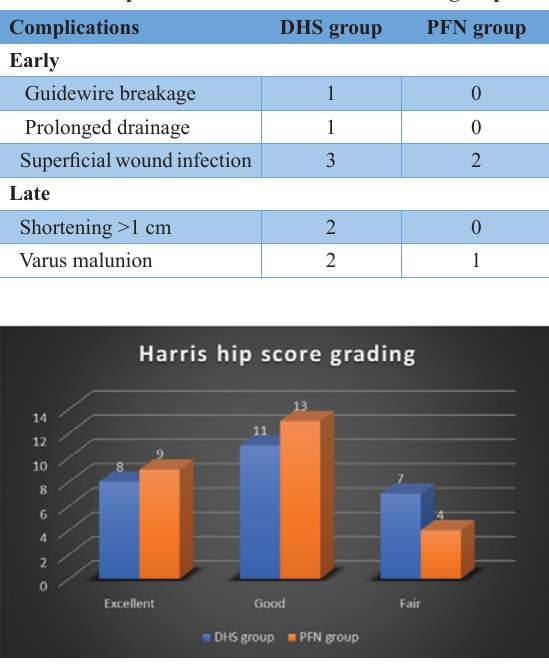
Figure 1. Functional outcome comparison between DHS